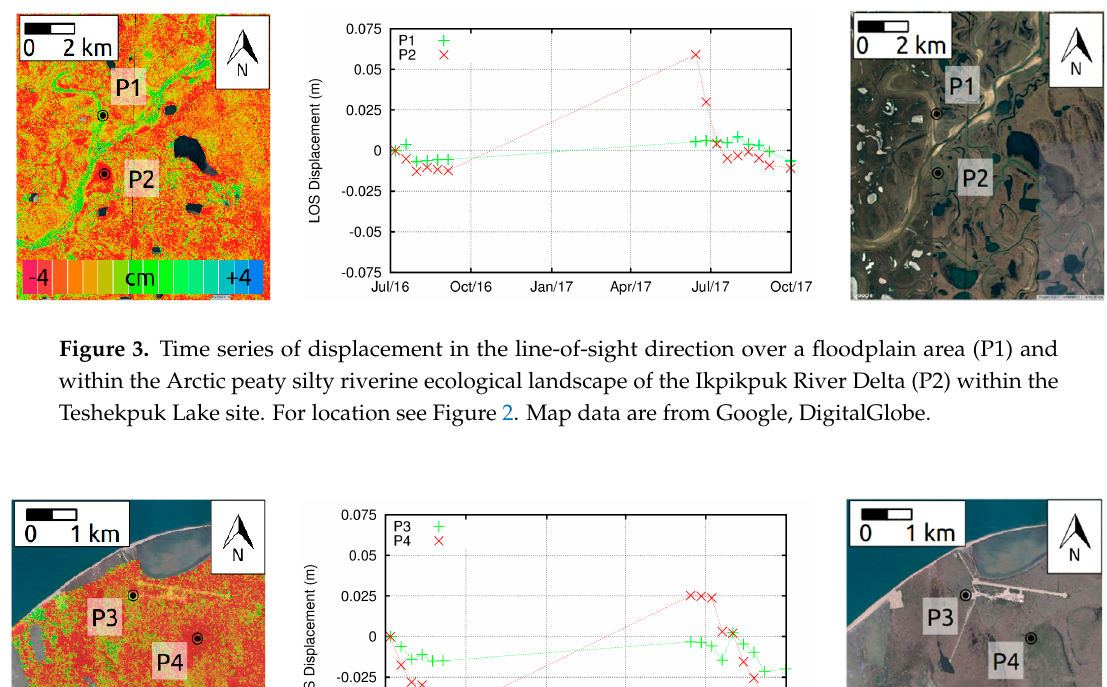
Figure 2. Subsidence map over Teshekpuk Lake (Alaska) from Sentinel ‐ 1 InSAR from 14 June to 12 October 2017. The white star indicates the reference position, the white boxes the enlargements of Figures 3 and 4.